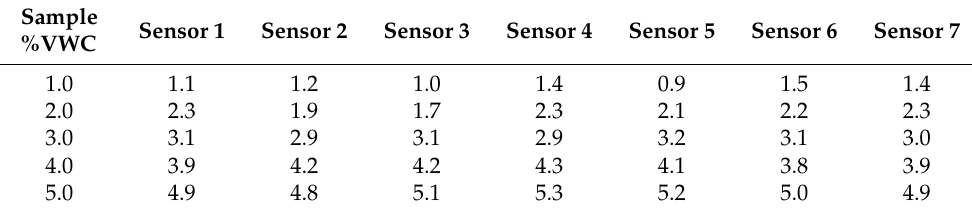
Table A1. VWC Measurements from each sensor once